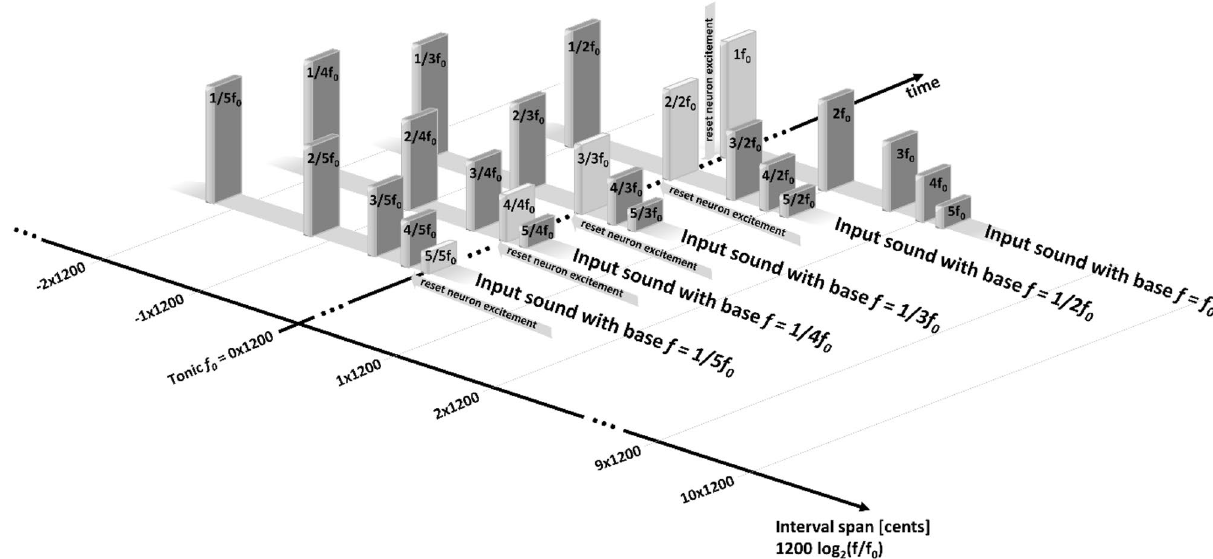
Figure 5. Explanatory snapshot presenting all the complex input sounds containing a selected tonic f 0 . The vertical 3D bars represent the harmonics within the complex sounds, with their height signifying the harmonic magnitude. The bars of the tonic are darker than those representing the other harmonics. In the image, we note the “reset neuron excitement” arrows, symbolizing that the said value is reset between the presentation of a given sound and its